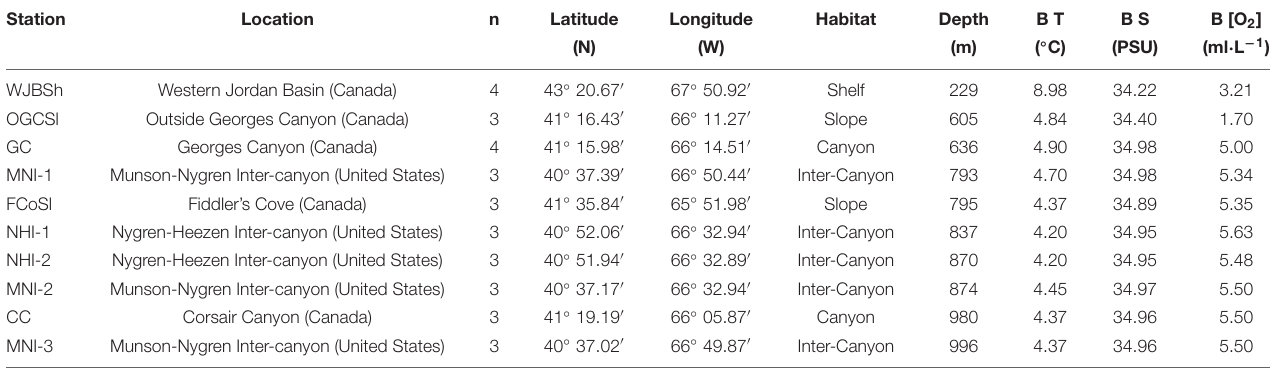
TABLE 1 | Description of stations and main environmental variables.